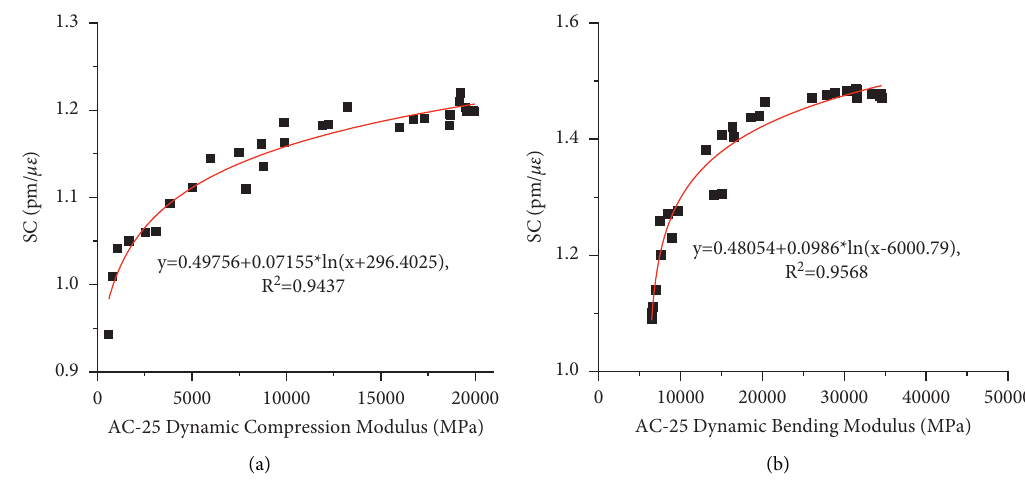
Figure 8: Modulus-based SC prediction model. (a) FBGS-1+ AC-25; (b) FBGS-2